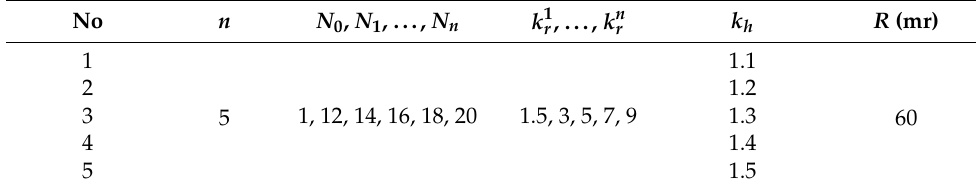
Table 2. Parameter combination of different radii of sampling circle.